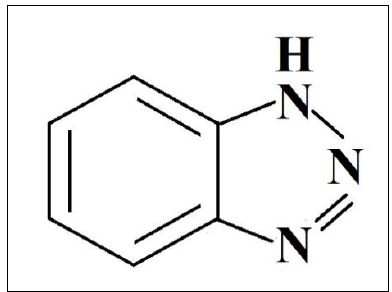
Figure 1. Structural formula of 1,2,3-benzotriazole.